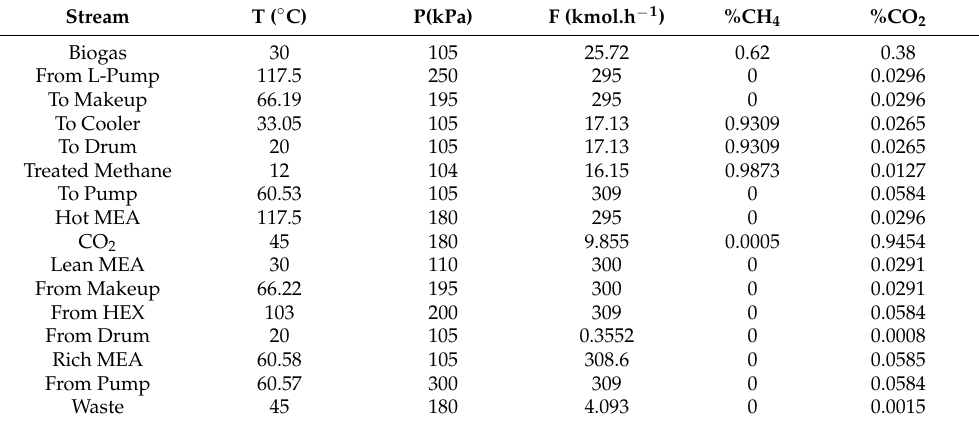
Table 9. Pressure and temperature for the main stream pretreated feed-chemical scrubbing.